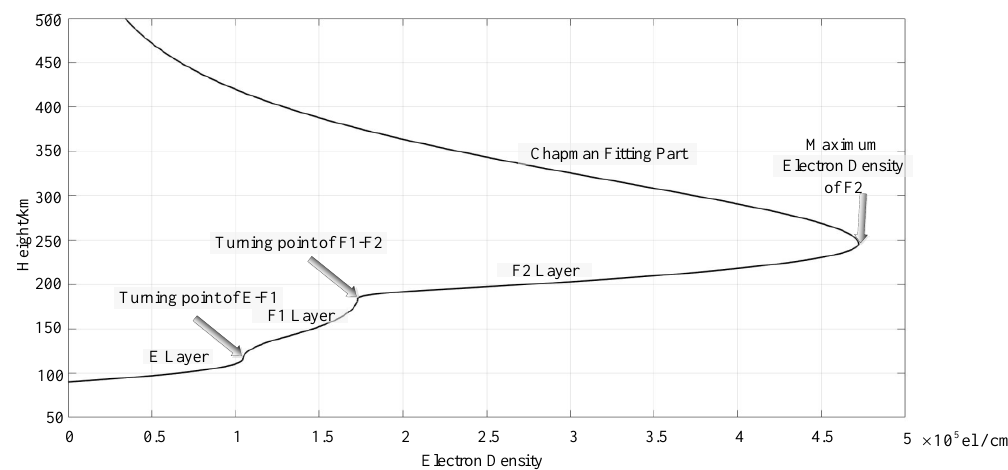
Figure 17. Electron density profile at the local time of 17:50, 5 January 2018.